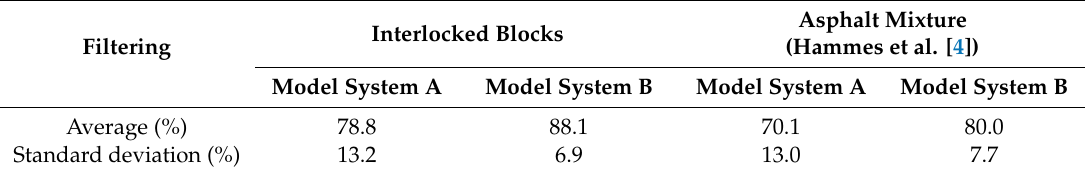
Table 5. Filtering capacity among the model